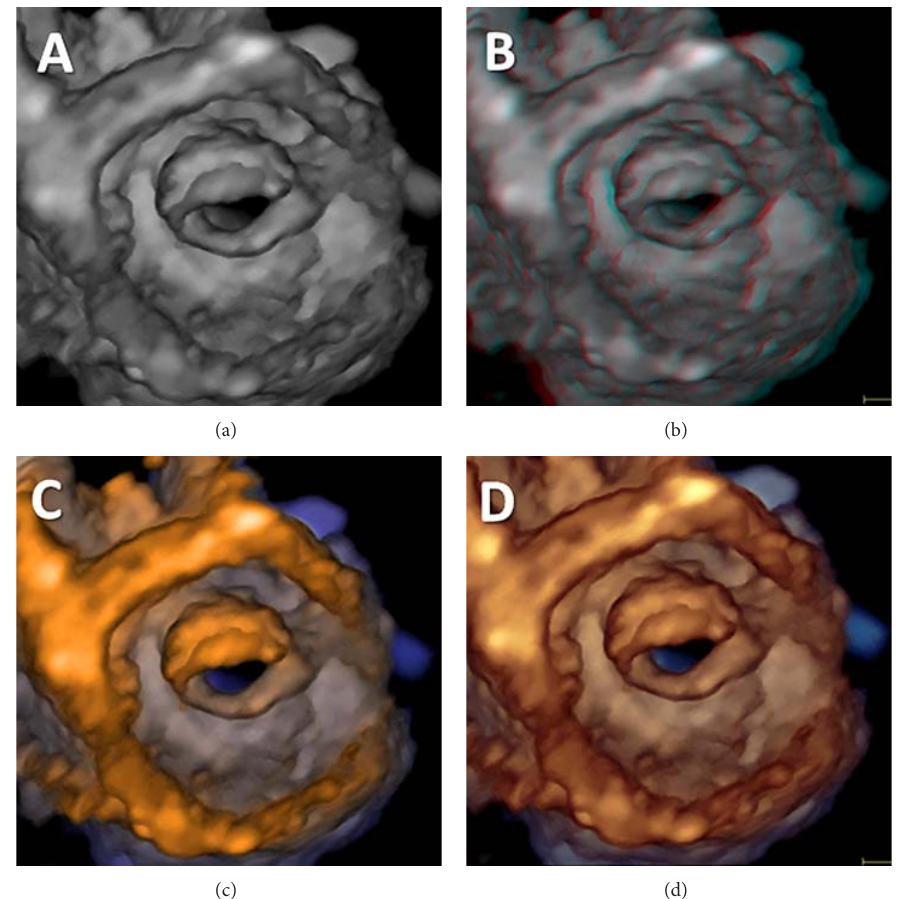
Figure 8: Examples of volume rendering in mitral stenosis using various depth-encoding colorizations: (a) grey; (c) bronze-blue; (d) copper- blue. (b) illustrates the stereo